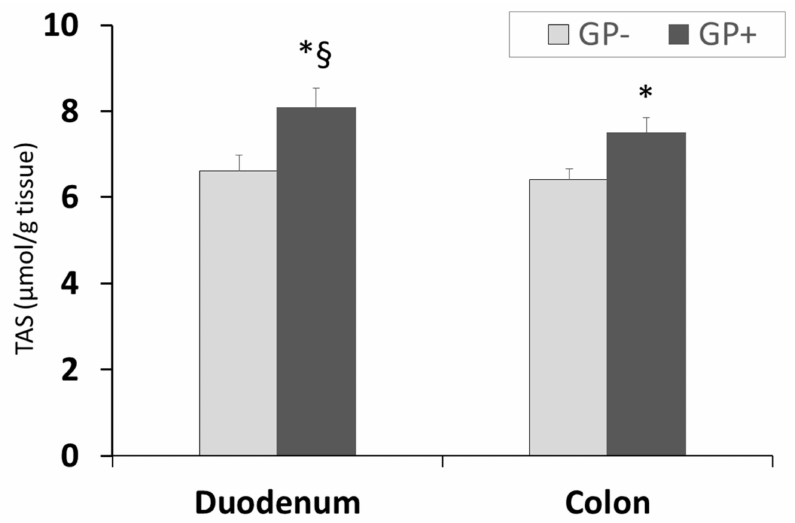
Figure 6. Total antioxidant status ( µ mol/g tissue) as determined by the TAS assay, in duodenum and colon samples (n = 10); * = statistically significant when GP − was compared with GP+, § statistically significant when compared with colon